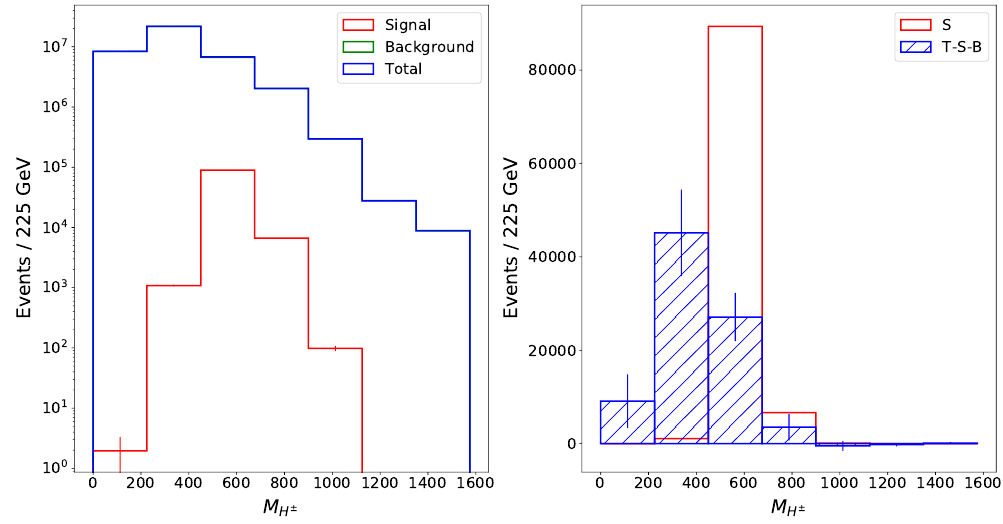
Figure 8 . The charged Higgs invariant mass distribution of the signal, background and total samples (left) and interference and signal (right) at parton level and without cuts in the h MSSM